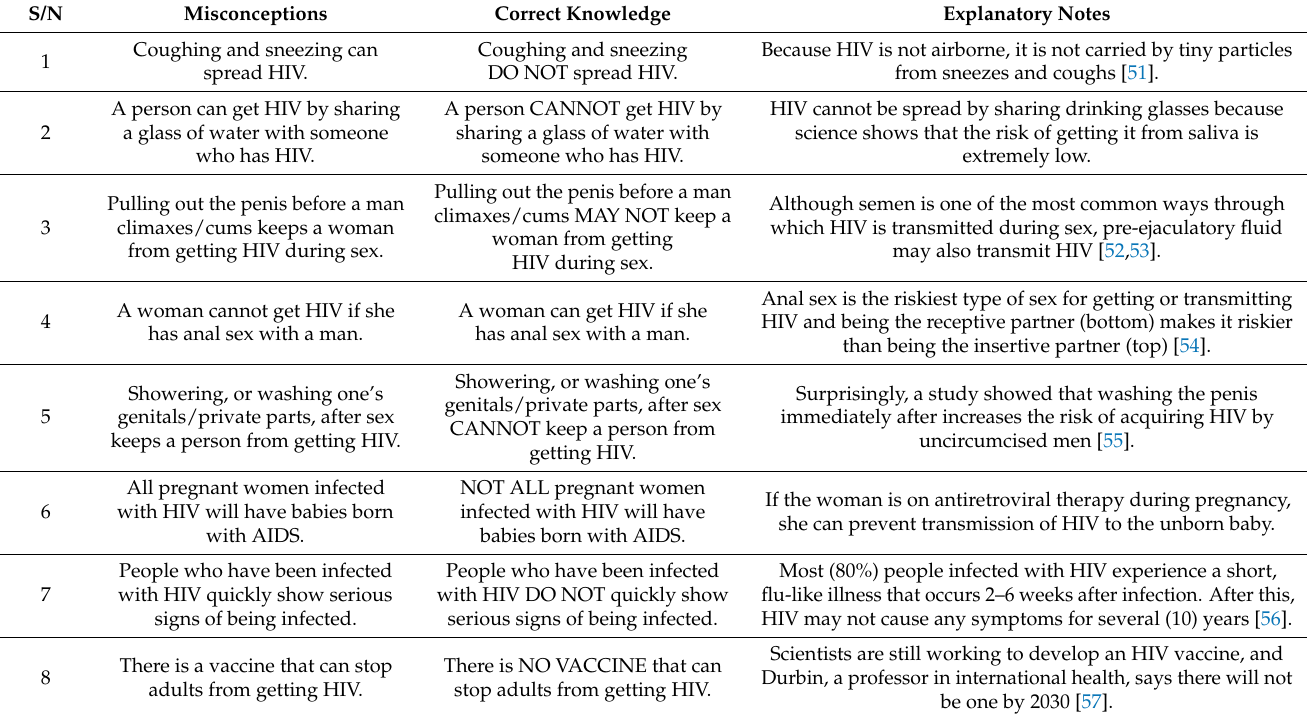
Table A1. Misconceptions Versus Correct Knowledge about modes of HIV